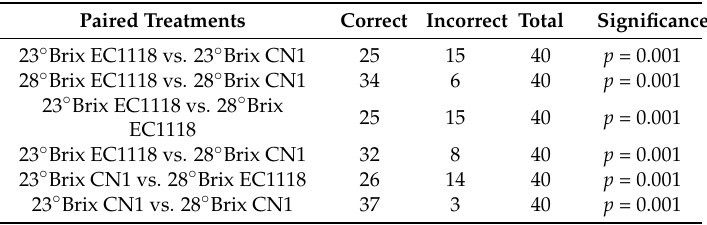
Table 4. Triangle test results to determine sensory differences between wines ( n = 40). Significance was assessed by comparing the proportion of correct responses to critical values